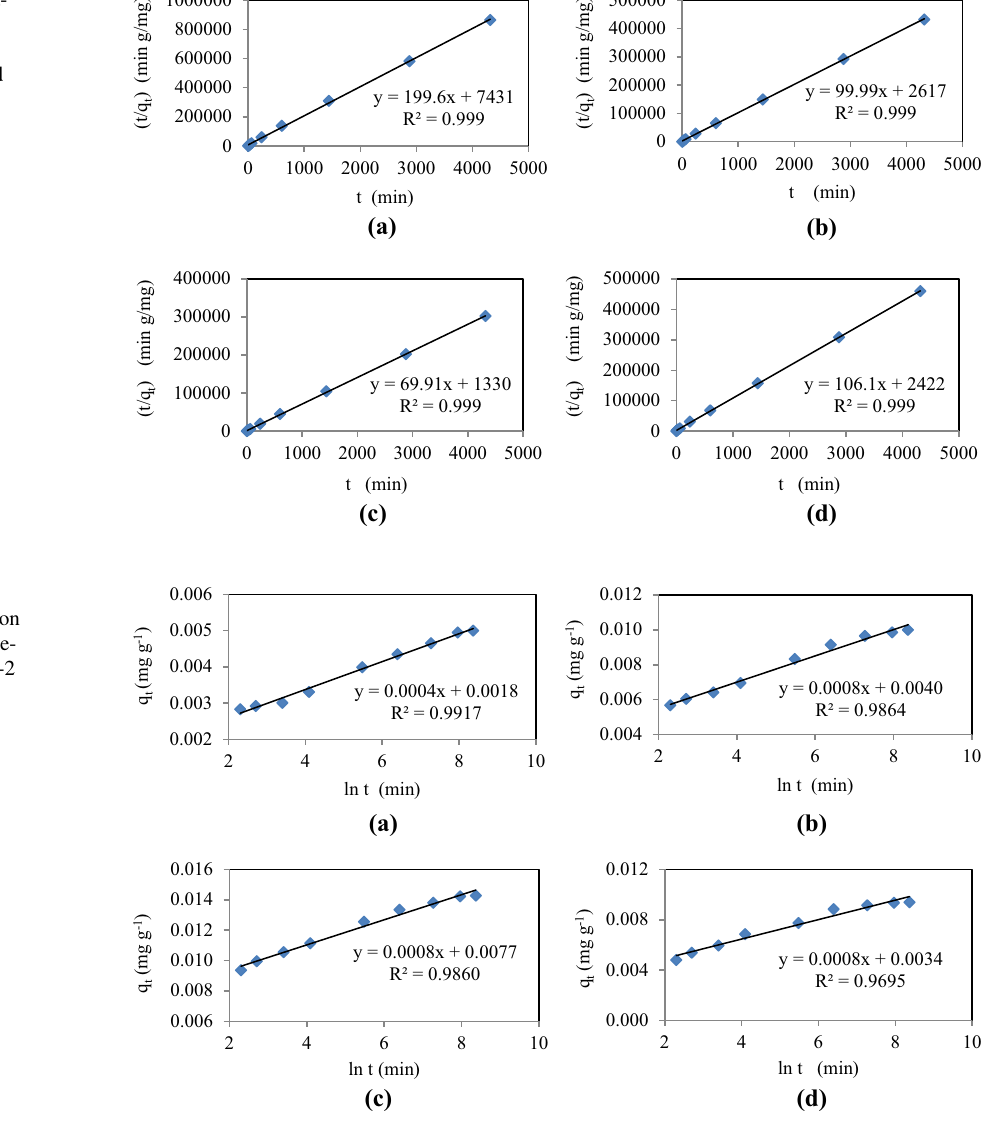
Fig. 9 Second-order lineariza- tion for F − adsorption from